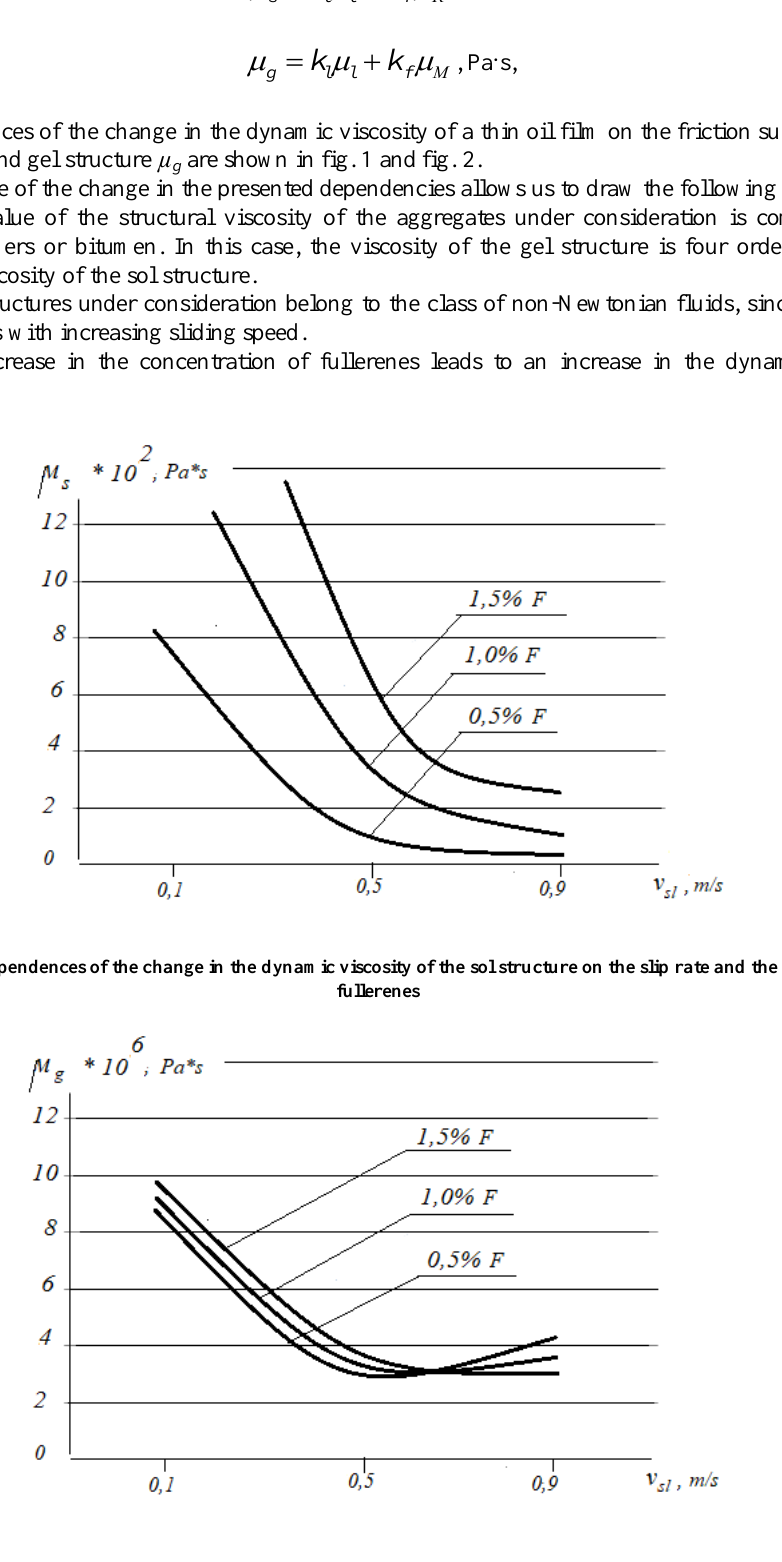
Fig.2. Dependences of the change in the dynamic viscosity of the gel structure on the slip rate and the concentration of fullerenes As follows from the simulation results for the structures of sol and gel, the properties of a non- Newtonian liquid are inherent. For an oil film on the friction surface, which has a gel structure, fig. 2, dynamic viscosity decreases 4 times with increasing sliding speed. This phenomenon can be explained by the